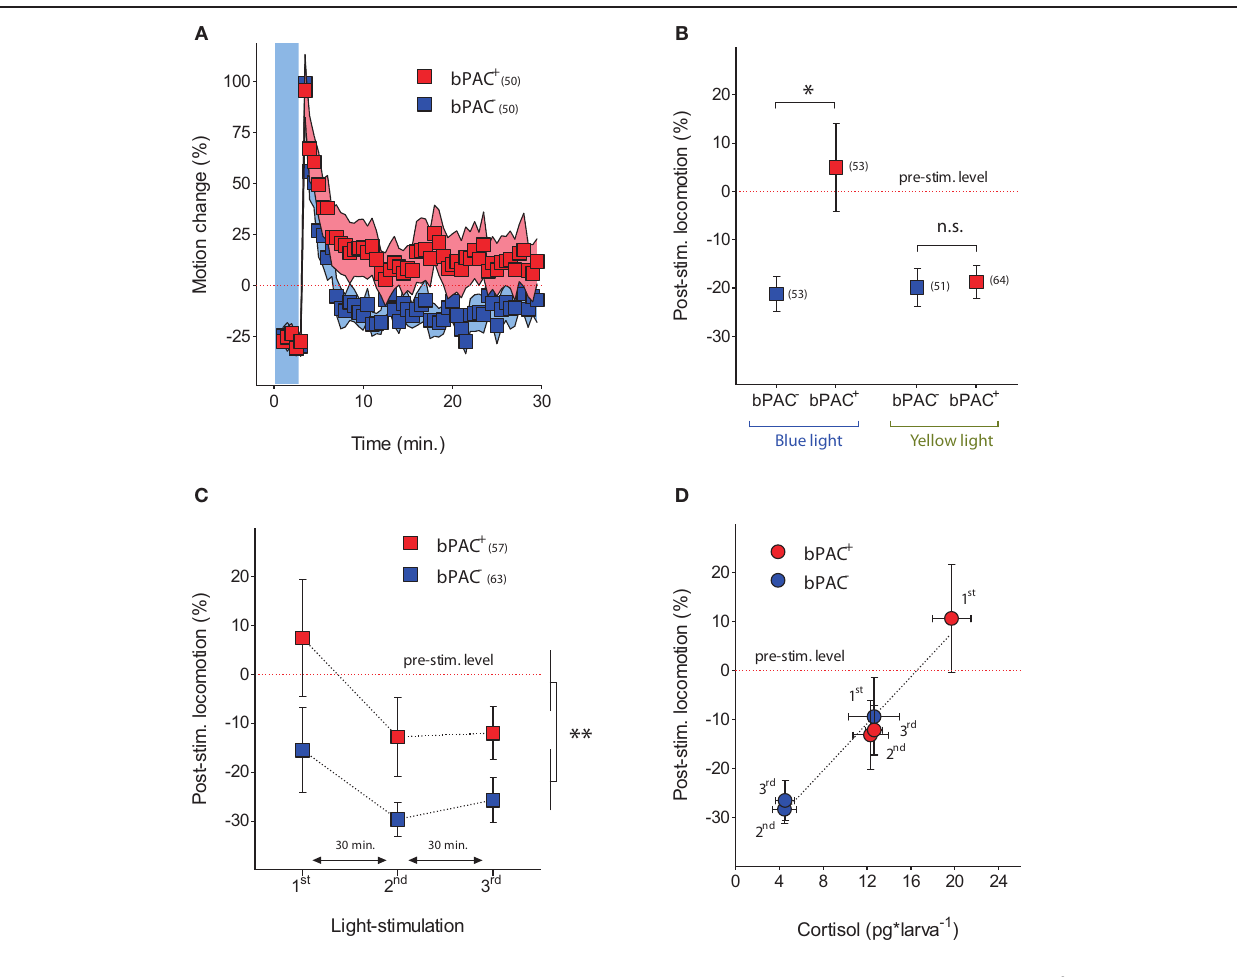
between groups at p < 0 . 05; light-power: 1mW ∗ cm − 2 ; sample size in parenthesis; see Materials and Methods for details on motion calculations). (C) Over multiple light exposures, post-stimulation locomotion is higher in the bPAC + larvae than in the bPAC − larvae (asterisks indicate statistical difference between the groups at p < 0 . 01; light-power: 2.8mW ∗ cm − 2 ; sample size in parenthesis). (D) Locomotion levels from bPAC + and bPAC − larvae plotted against corresponding cortisol levels; note how post-stimulation locomotion shows linear dependence of past cortisol